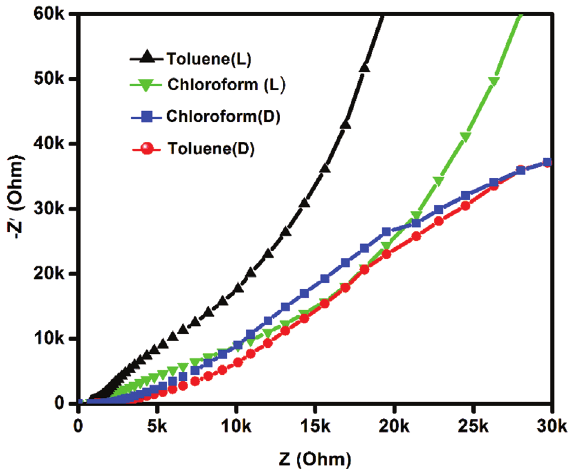
Figure 6: Nyquist plot of IBS thin films developed from homogeneous solution of precursors (1) and (2) in toluene and chloroform under illumination and without illumination .